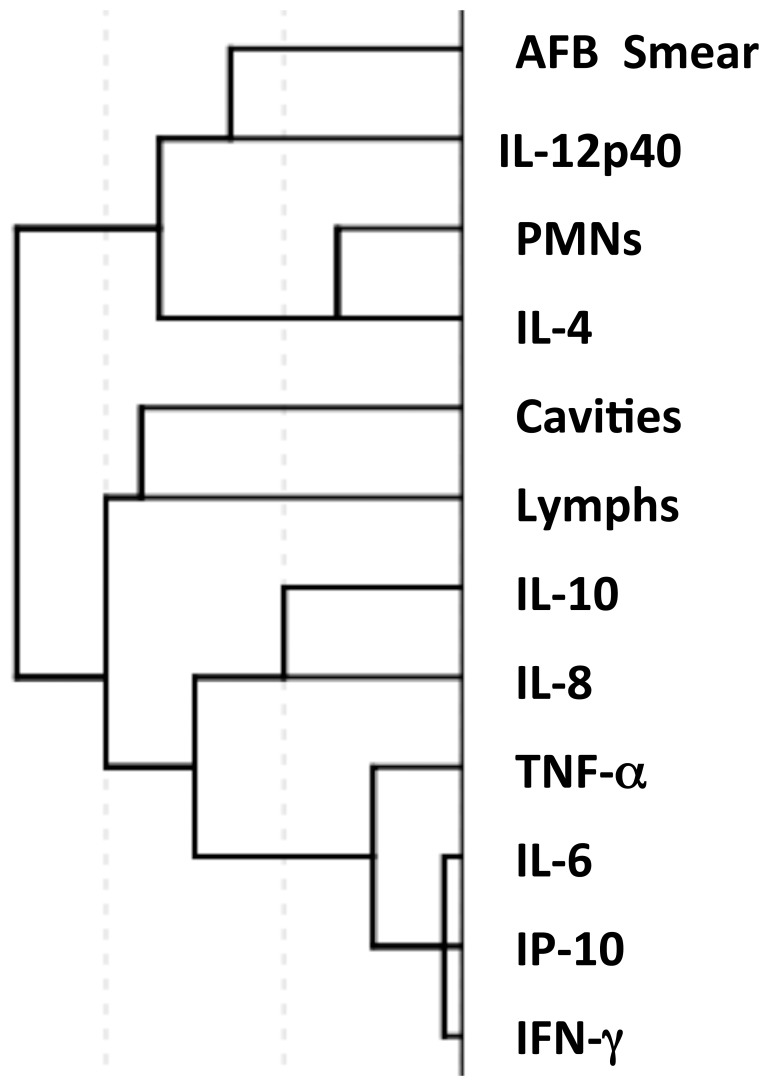
Hierarchical clustering of results from sputum smear for AFB, BAL cell differential, BAL cell culture supernatants and cavities on chest radiograph demonstrates AFB smear clusters with IL-4, IL-12 p40 and BAL PMN.